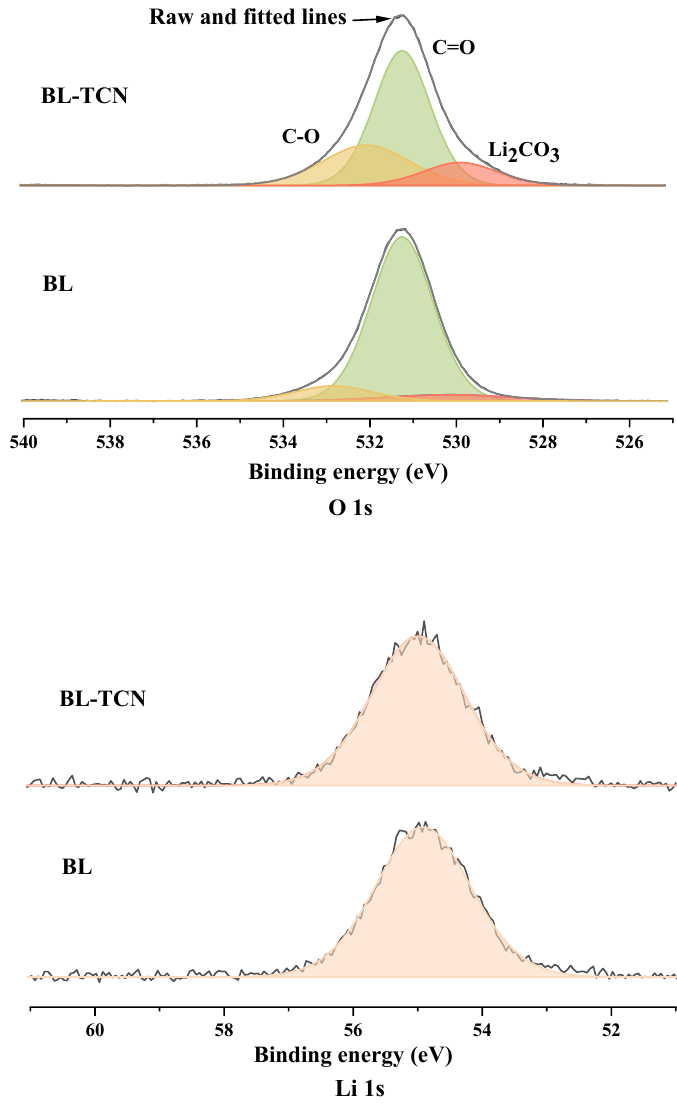
Figure 3. O 1s and Li 1s XPS spectra of anode after 15 cycles with BL and BL-TCN electrolytes.